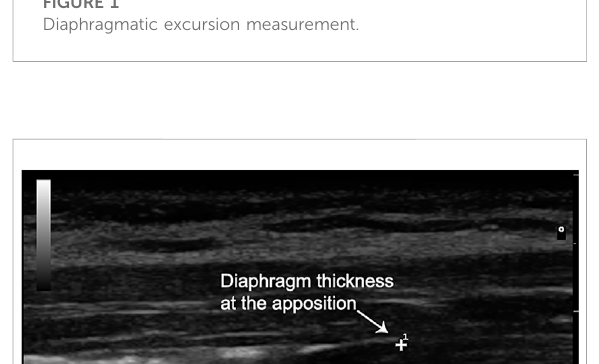
FIGURE 1 Diaphragmatic excursion measurement.